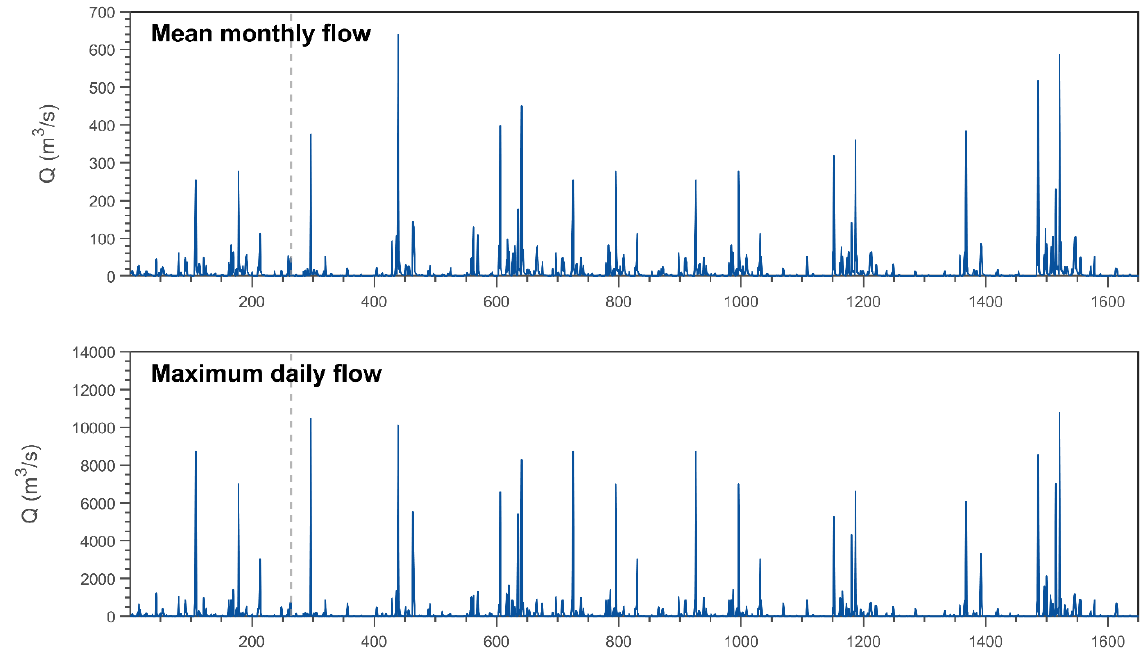
Figure A6. Mean monthly (top) and maximum daily (bottom) synthetic inflow hydrographs of additional scenario #4. The dashed line indicates the construction of the Wivenhoe